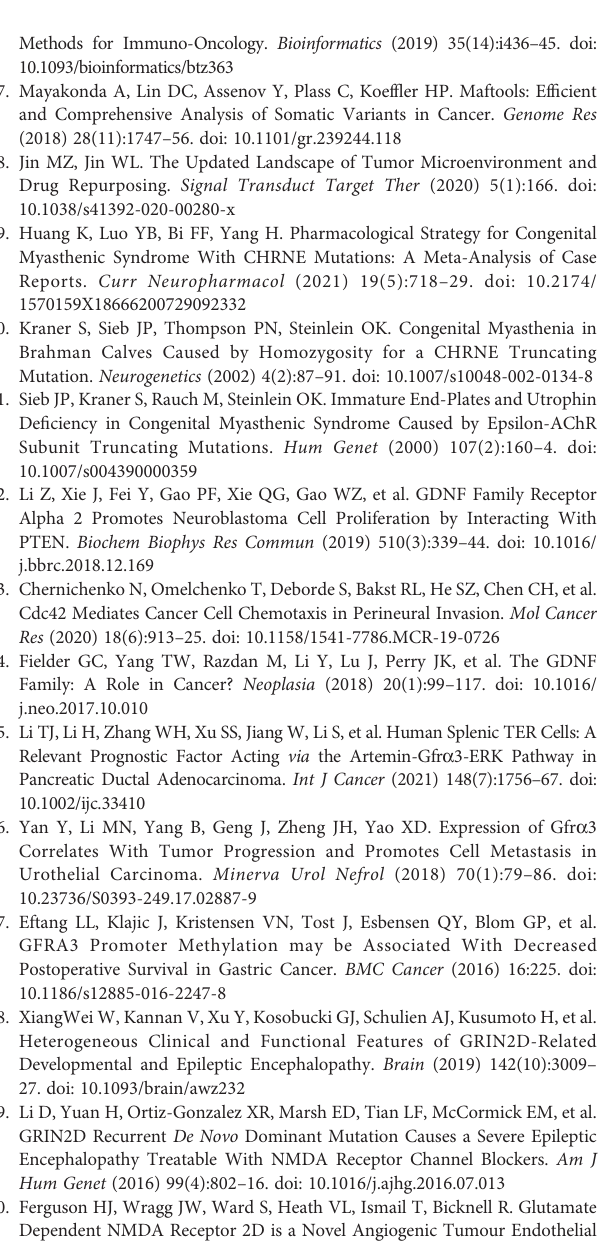
Supplementary Figure 5 | Differential expression and enrichment analysis of high and low GFRA3 expression groups. Supplementary Figure 6 | Differential expression and enrichment analysis of high and low GRIN2D expression groups. Supplementary Figure 7 | Comparisons of immune status and stemness between high and low GFRA2 expression groups. Supplementary Figure 8 | Comparisons of immune status and stemness between high and low GFRA3 expression groups. Supplementary Figure 9 | Comparisons of immune status and stemness between high and low GRIN2D expression